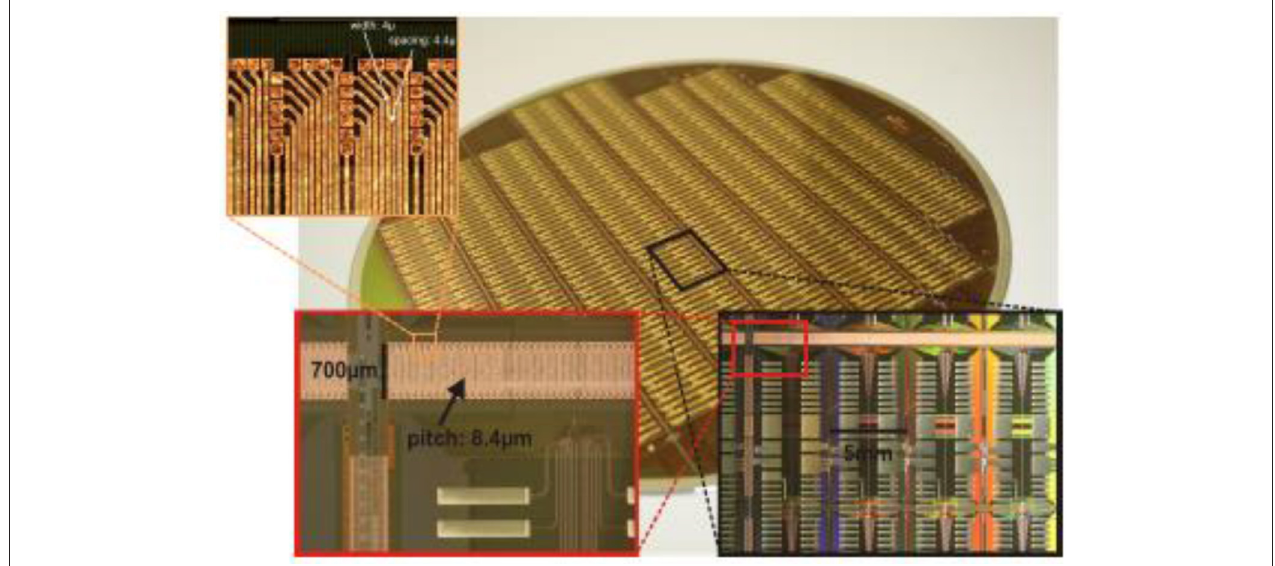
FIGURE 14 | L1 post processing. Main picture: Photograph of a post-processed wafer. Enlargements: bottom right: top-left corner of a reticle. The large stripes connect the wafer to the main PCB. Bottom left: the L1 connections crossing the reticle border. Top left: 4- µ m wide individual metal traces of the L1 connections terminating at the pad-windows of the top reticle.